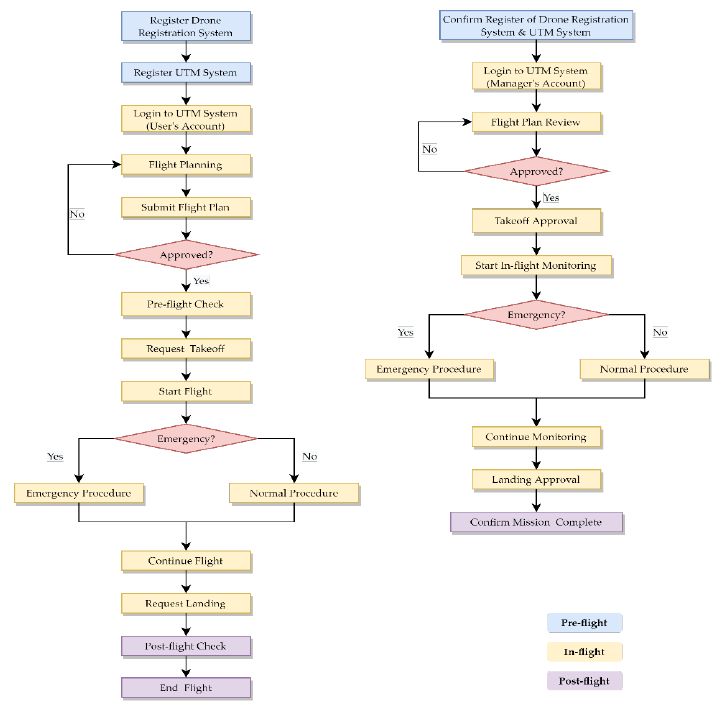
Figure 3. UTM operational procedures (left: for users, right: for managers).